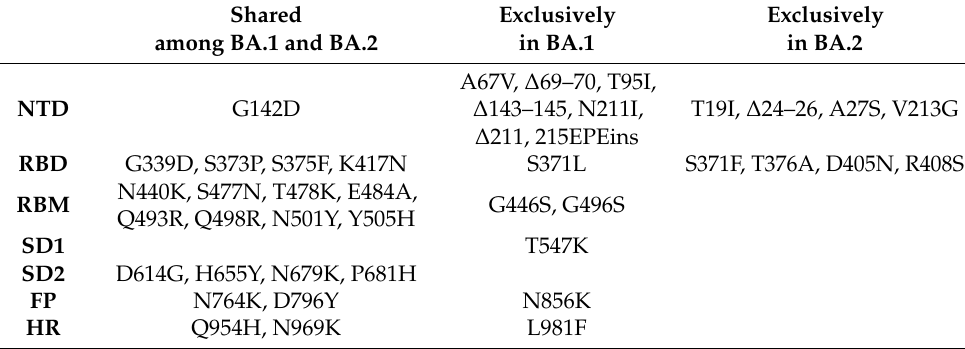
Table 1. Comparison between the BA.1 and BA.2 mutational profiles in the SARS-CoV-2 spike. Abbreviations used: NTD (N-terminal domain), RBD (receptor-binding domain), RBM (receptor- binding motif), SD1 (subdomain 1), SD2 (subdomain 2), FP (fusion peptide), and HR (heptad